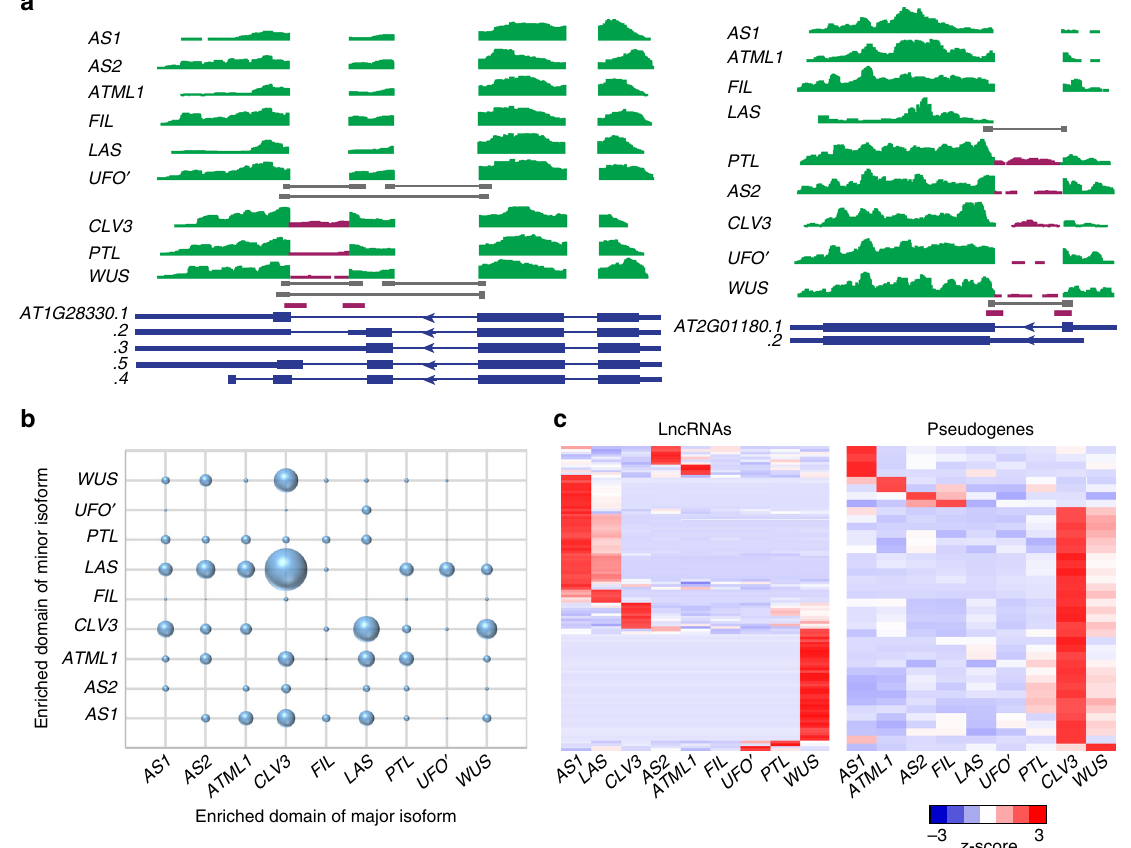
Fig. 3 Domain-speci fi c expression of AS and lncRNAs. a Examples of domain-speci fi c expression of alternative splicing. Reads distribution of two genes are given. TAIR10-annotated gene models (i.e., isoforms) for each locus are represented as blue boxes in the bottom. Areas in purple color indicate reads which were differentially distributed among isoforms, while those in green are common ones. Selected reads covering exon – exon junctions are highlighted by gray bars. Purple boxes represent reads containing exon – intron junction sequences in some isoforms. b Enriched domain of alternative splicing. The size of the balls represents numbers of enriched AS genes. c Expression pattern of domain-enriched long noncoding RNAs and pseudogenes. Complete linkage hierarchical clustering was performed on relative expression ( z -score) as described in the AXILLARY MERISTEMS1 , and LATERAL ORGAN FUSION1 (Fig. 4b, Supplementary Data 7). ARABIDOPSIS THALIANA HOMEOBOX PROTEIN29 and PTL within this model are upstream regulators of LAS and CUC2 , respectively 16 . RABBIT